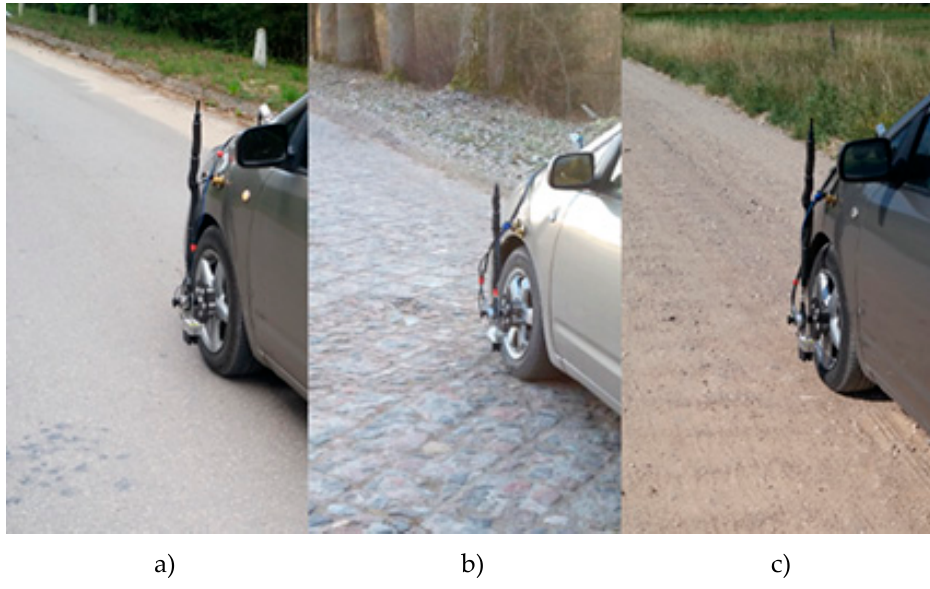
Figure 5. Selected road surfaces for test braking: (a) asphalt, (b) cobblestone, (c) gravel.